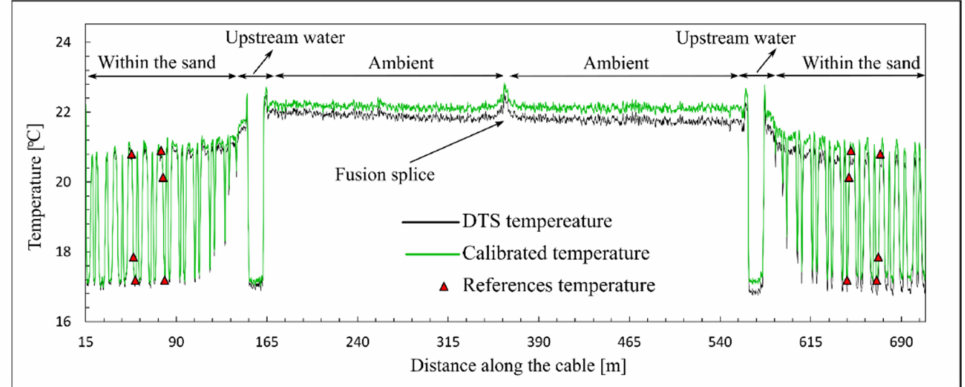
Figure 7. DTS measured temperature and calibrated temperature at 15:50.